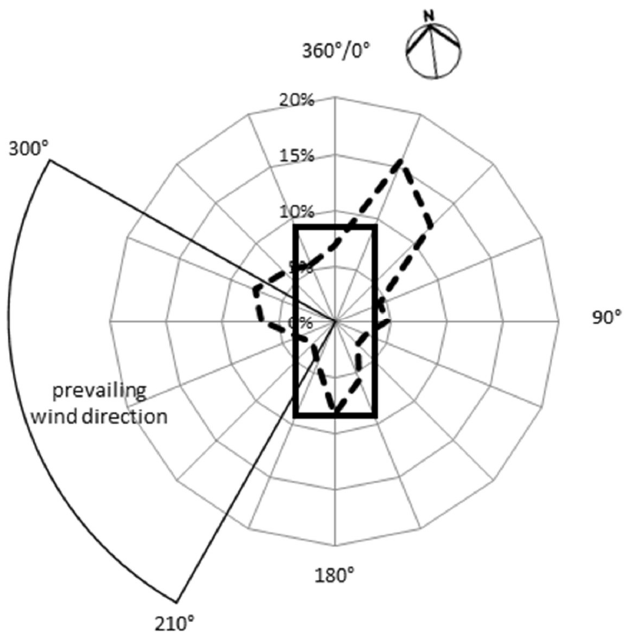
Figure 2. Plot of a wind rose with the selected angle of the upstream flow (210°–300°) specific for this barn building to realise cross flow ventilation (solid line: alignment of the barn to the prevailing wind direction; dashed line: frequency of the overall wind direction and a minimum wind velocity (≥0.7 m/s) per hour over the whole study ( n = 3395)). Compass direction north (N) ≙ 345°.